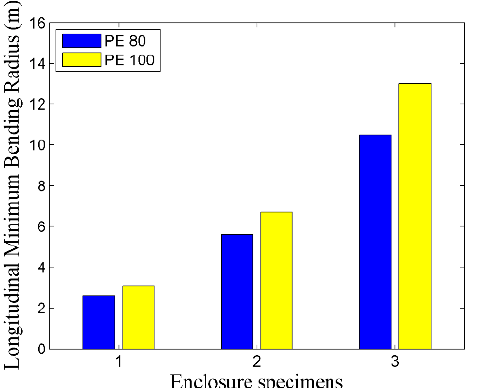
Figure 4. Flexibility comparison of different enclosure specimens described in Table 2.